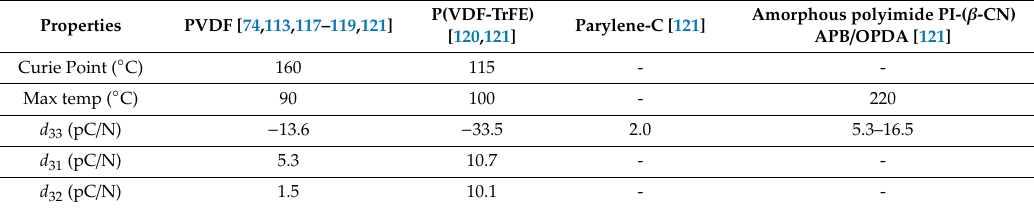
Table 2. Properties of bulk